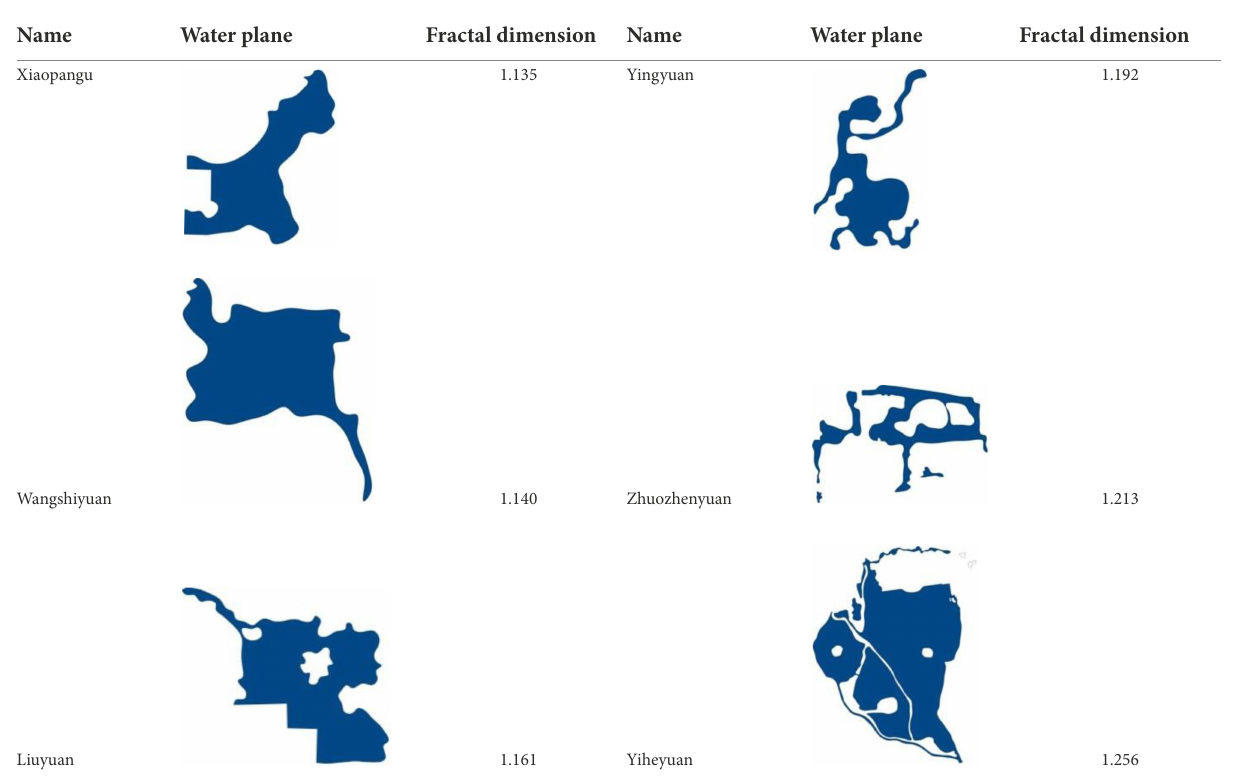
TABLE 8 Water plane form and fractal dimension.